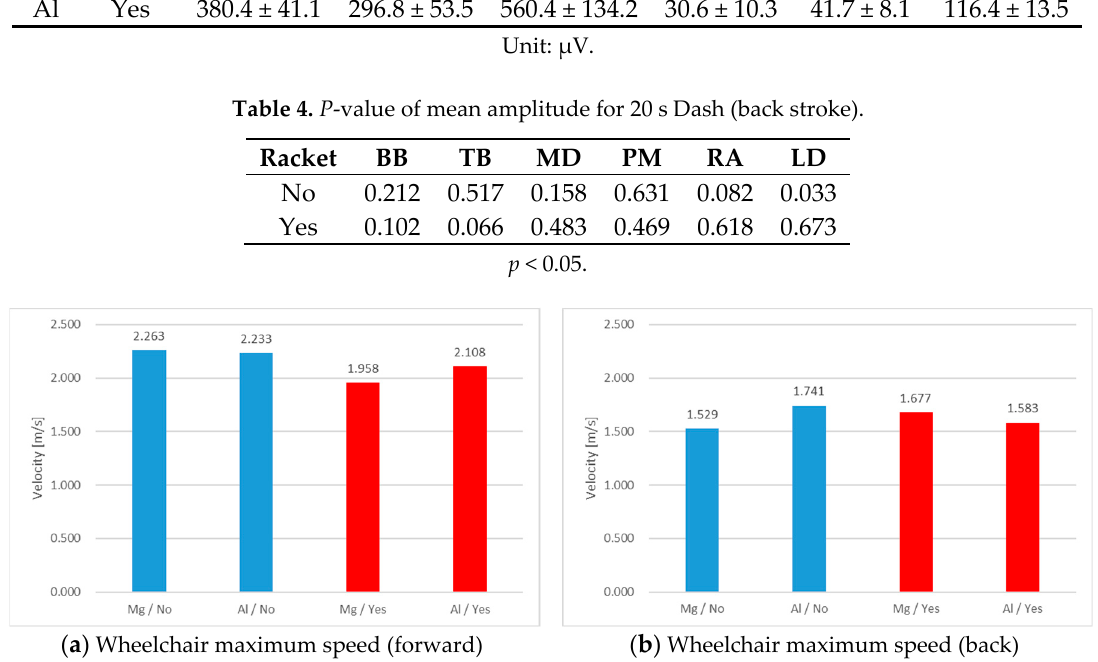
Figure 2. Wheelchair maximum speed. From the left of each figure, Mg alloy no racket, Al alloy no racket, Mg alloy racket, Al alloy racket: ( a ) forward stroke; ( b ) back stroke. Each figure was created using three forward and four backward trials for 20 s.